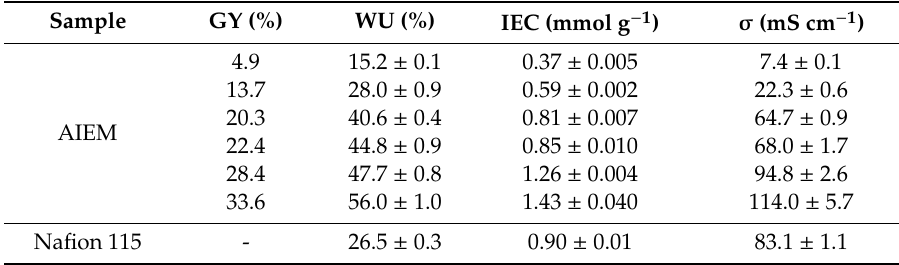
Table 2. The water uptake (WU), ion exchange capacity (IEC), and conductivity of AIEMs with di ff erent GYs and the Nafion 115